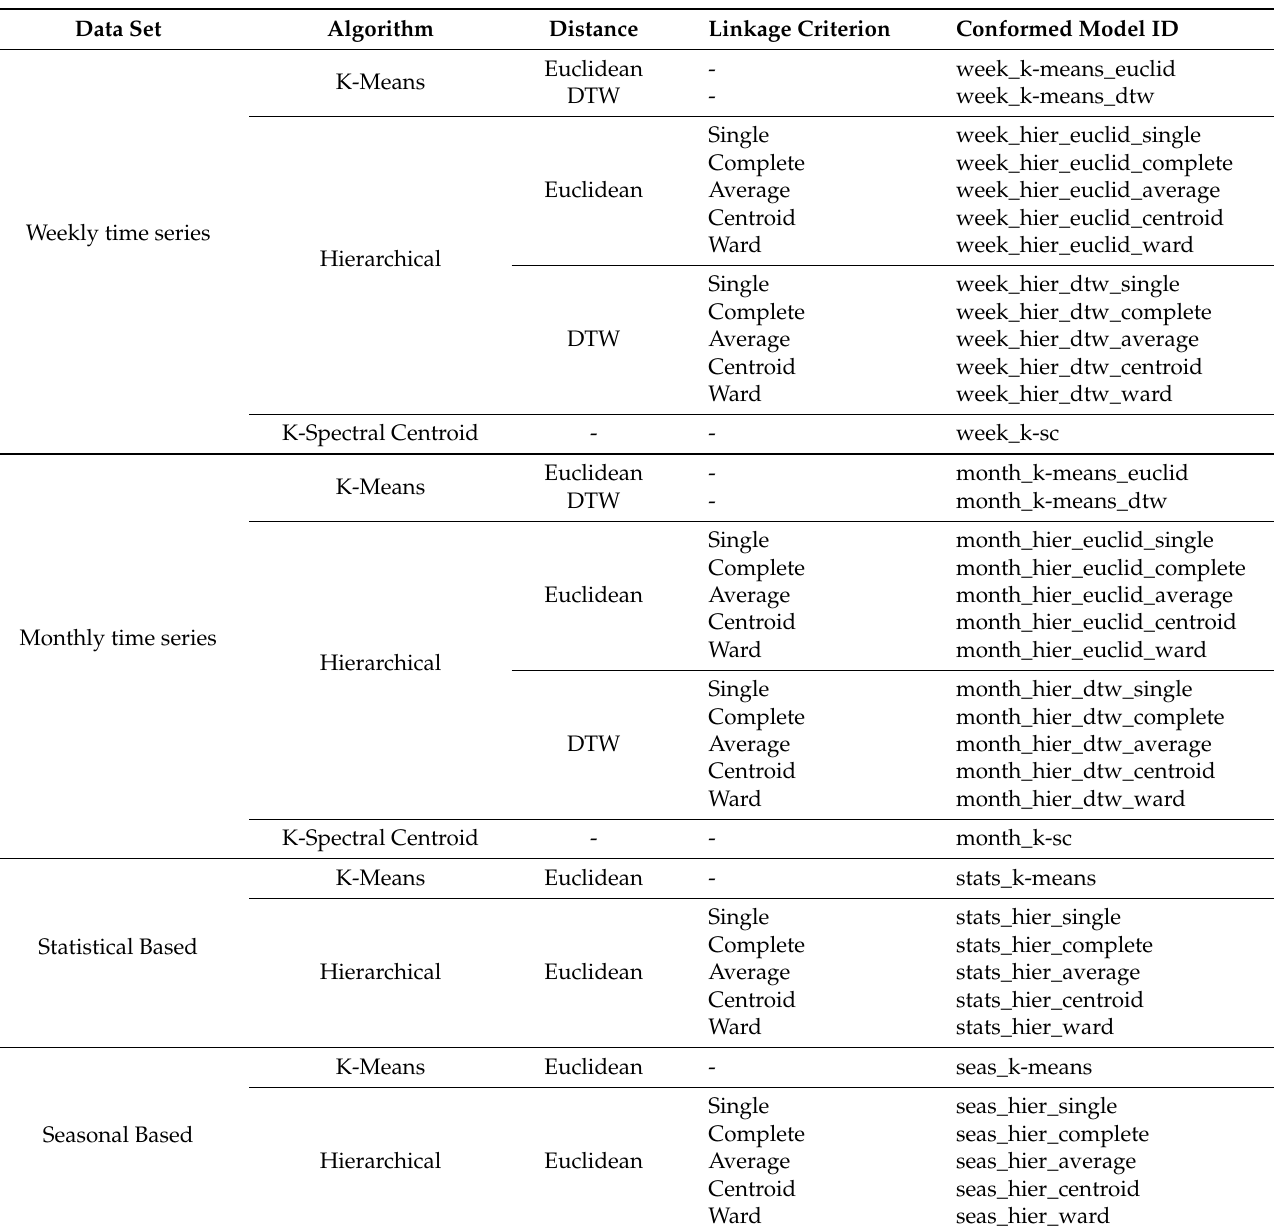
Table 3. Description of the proposed